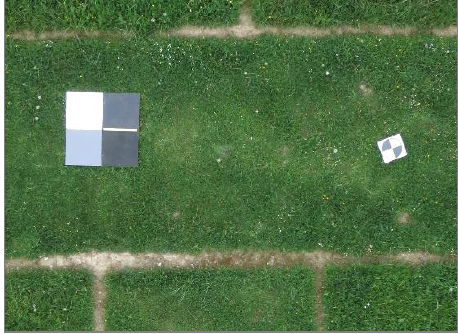
Figure 3. Reference targets (left) & ground control point (right) at the Rengen Grassland Experiment (Photo G. Bareth 2014). Figure 4. UAV-based RGBVI values for 6 th April (A) and 18 th May (B). Capital letters correspond to fertilizer treatments (Ca (A), CaN (B), CaNP (C), CaNPKCl (D), CaNPK 2 SO 4 (E)). Black Polygons represent areas to compute mean values per